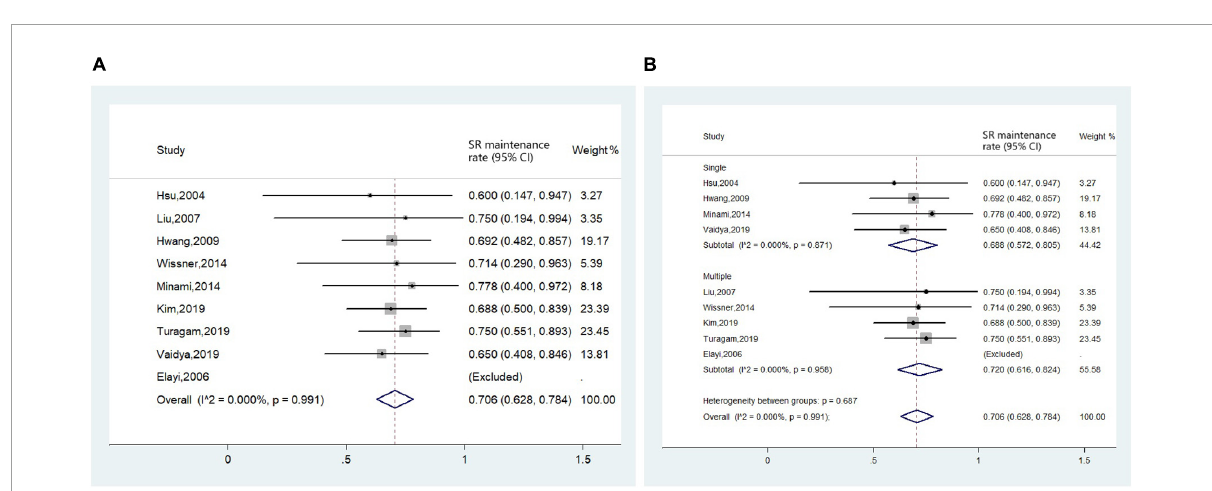
FIGURE7 Forest plot of the included studies for the efficacy endpoint of (A) long-term sinus rhythm (SR) maintenance rate in all patients and (B) subgroup analysis of long-term sinus rhythm maintenance rate based on times of ablation procedures (single procedure and multiple procedures).